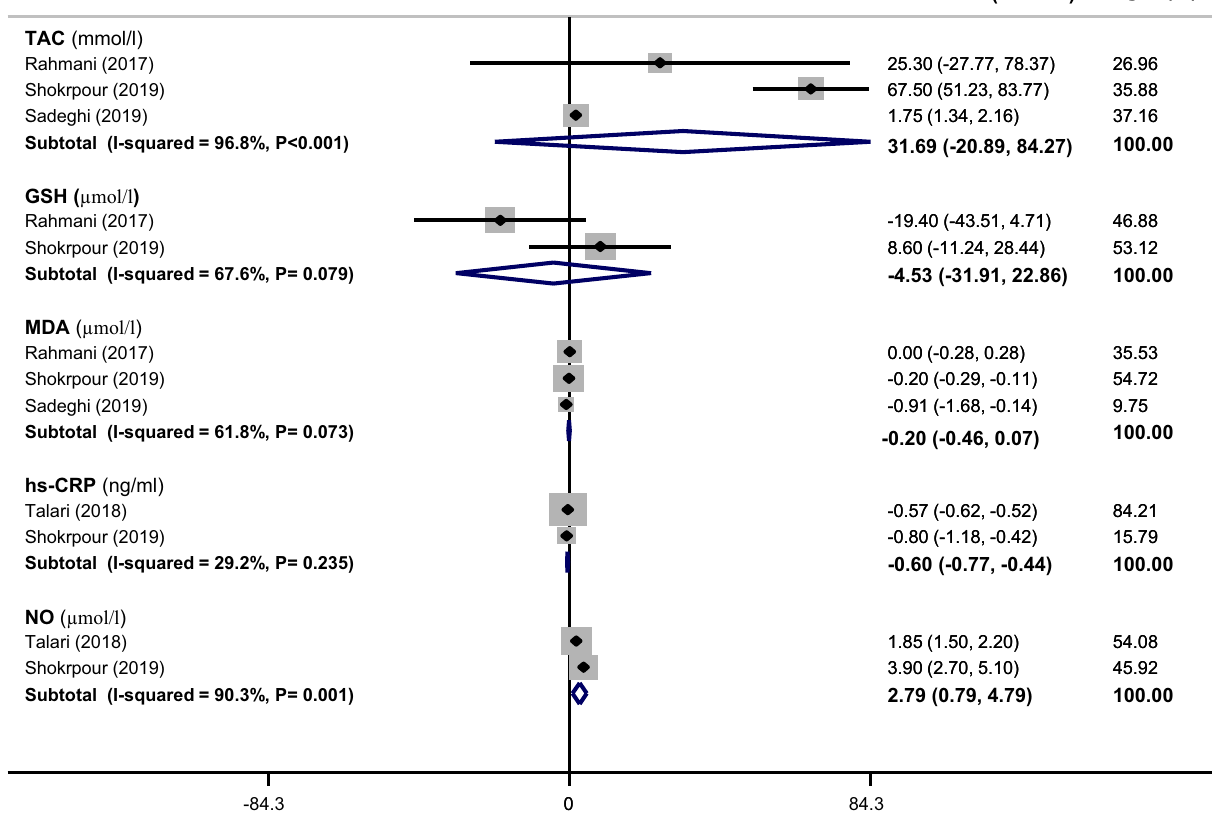
Figure 3. Forest plots of the effect of vitamin E supplementation or vitamin E along with omega-3 or magnesium supplementation on biomarkers of inflammation and oxidative stress. If the diamond does not touch the vertical line (or the line of null effect), the overall effect is statistically significant. A significant decrease in serum level of hs-CRP (WMD − 0.60 ng/mL, 95% CI − 0.77 to − 0.44) and a significant increase in the serum level of NO (WMD: 2.79 µmol/L, 95% CI 0.79–4.79) were found in PCOS patients after vitamin E supplementation or vitamin E along with omega-3 or magnesium supplementation in comparison to